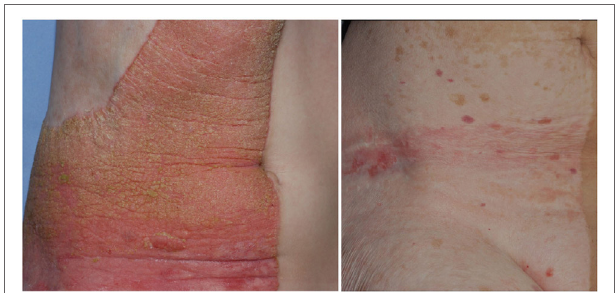
FiGURe 2 | Unilateral epidermal nevus in a patient with CHILD syndrome, before (left panel) and after 5 years topical application of a simvastatin/ cholesterol cream (right